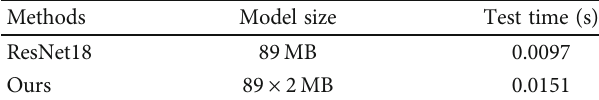
Table 3: Size and test time of di ff erent